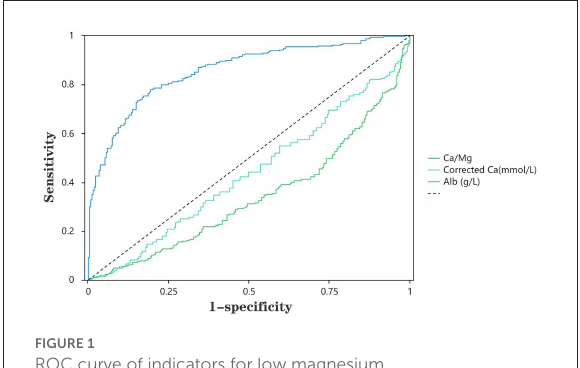
FIGURE1 ROC curve of indicators for low magnesium.